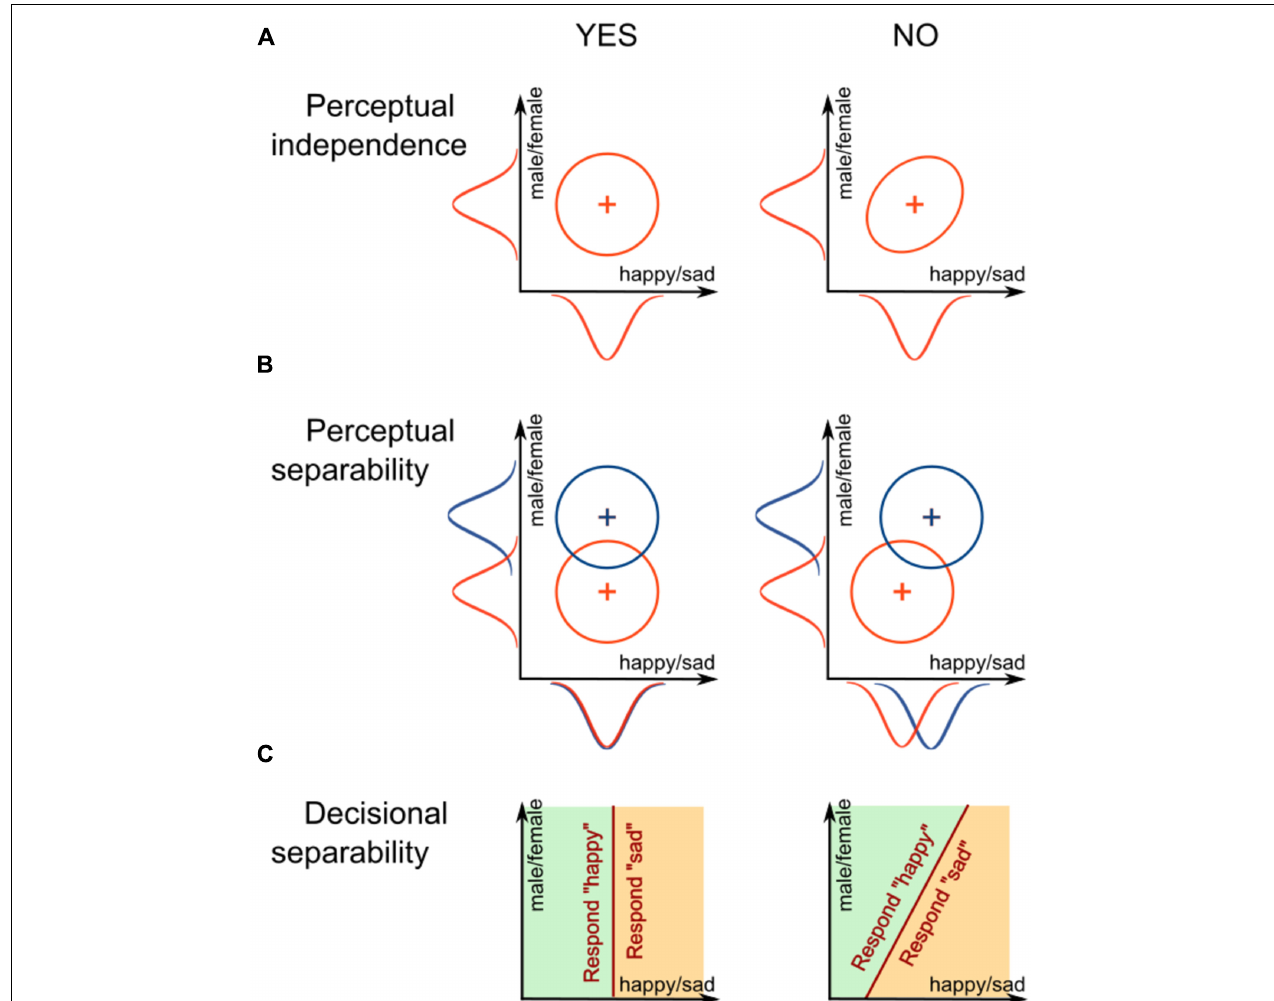
FIGURE 2 | Schematic representation of different forms of interaction between dimensions defined in general recognition theory: (A) perceptual independence, (B) perceptual separability, and (C) decisional